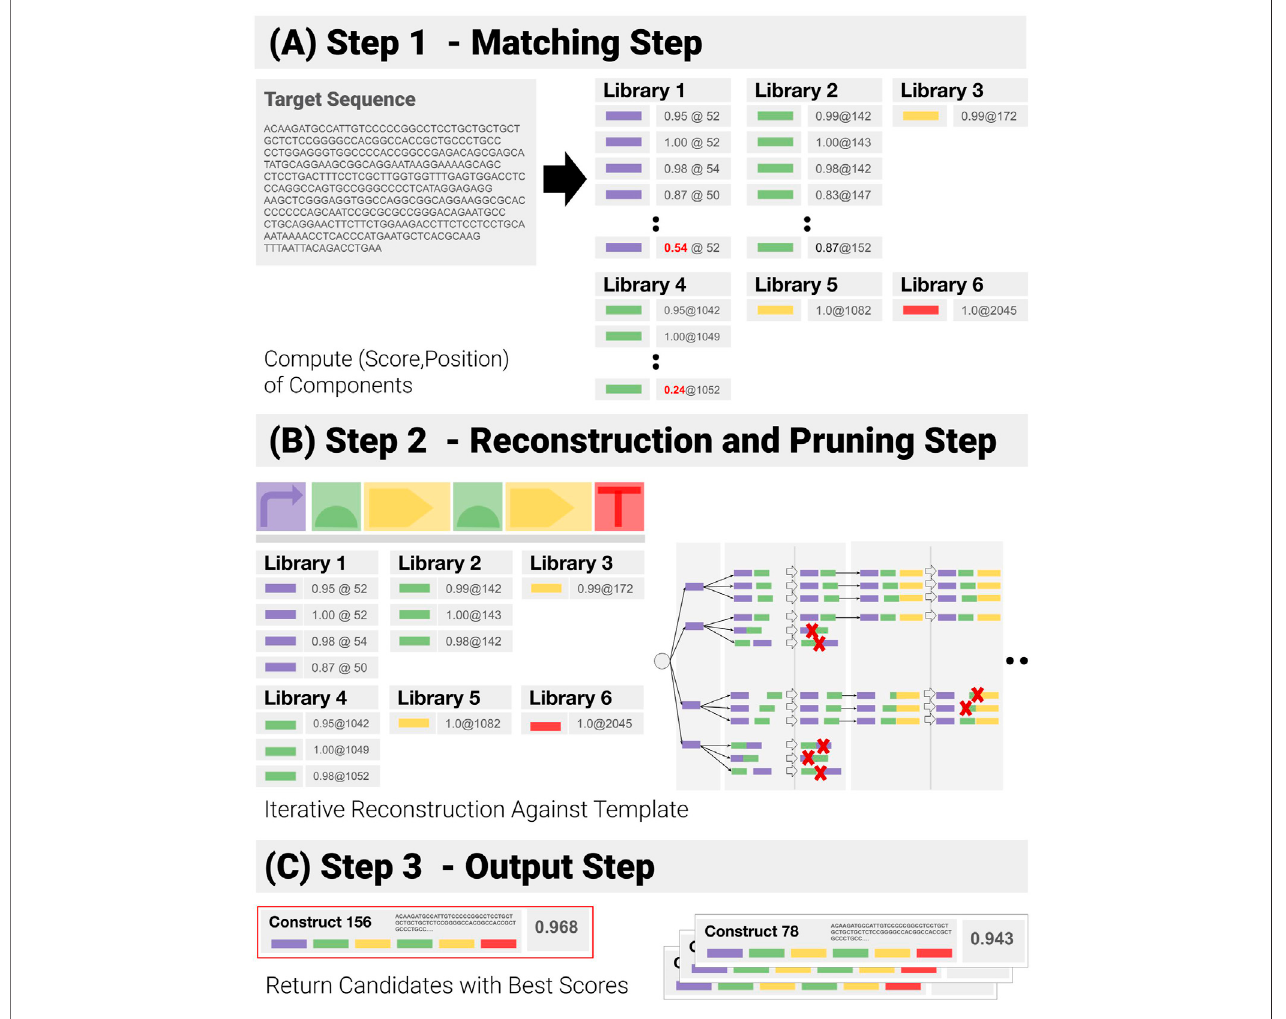
FIGURE 5 | Successive Steps of the Construct-Matching Algorithm CM_1. (A) Step 1 - CM_1 fi rst looks for all components in the target sequence. Poor matches (low score, in red) are pruned out at this early stage. (B) Step 2 - Components identi fi ed in Step 1 are recombined into a list of all admissible constructs. Dynamic reconstructionwasimplemented.Amatchingscoreisgeneratedfromtheindividualcomponentmatchingscoresforallpossibleconstructs. (C) Step3-Constructswith the highest scores are returned.